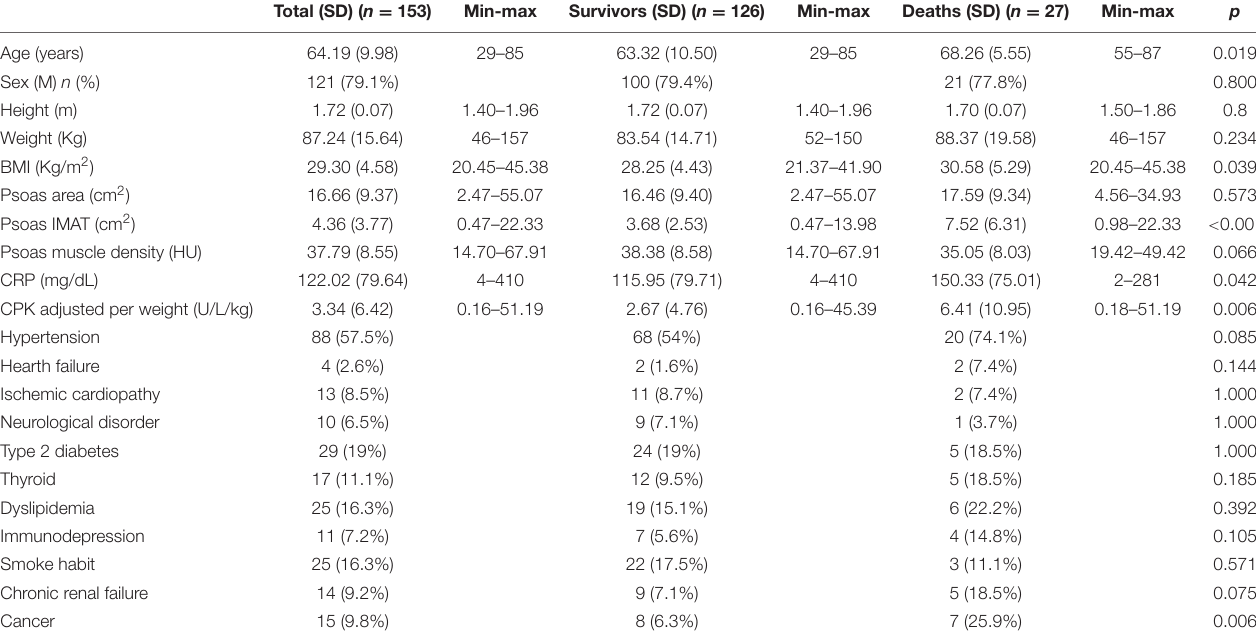
TABLE 1 | Characteristics of the study population according to mortality